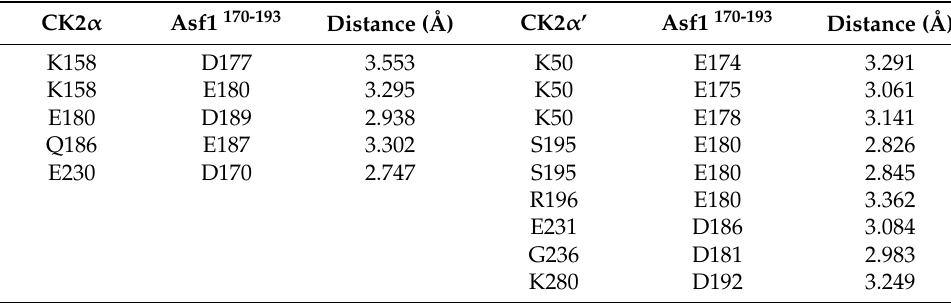
Table 1. List of hydrogen bonds formed between CK2 catalytic subunits and Asf1 170-193